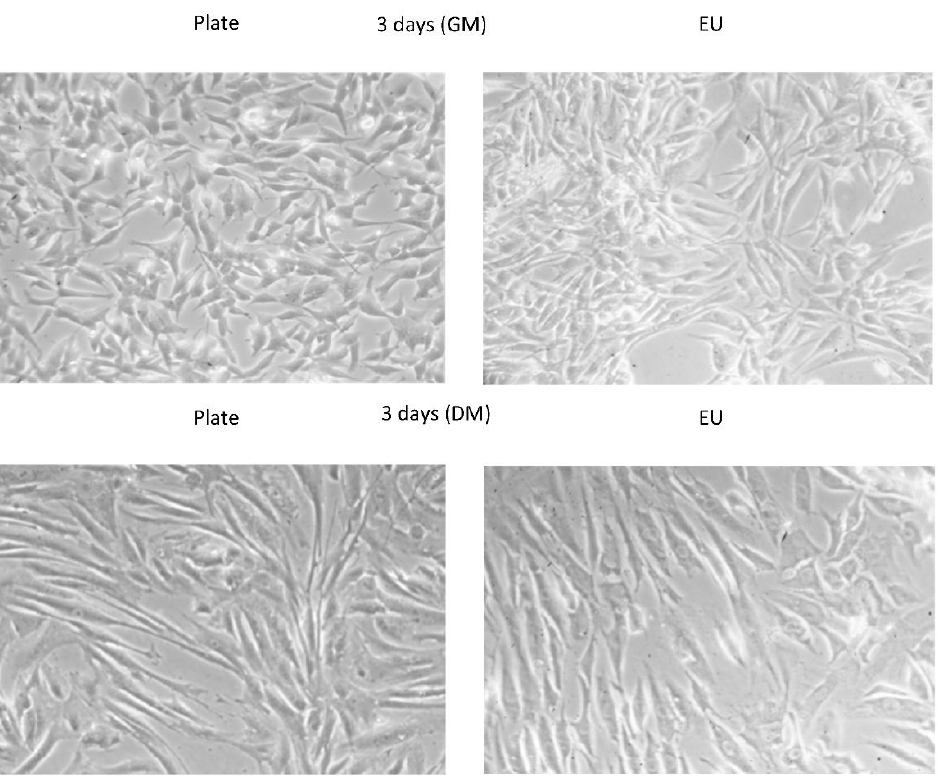
Figure 3. Myoblasts and myotubes after 3 days of culture in proliferation (GM) or differentiation (DM) conditions as viewed by phase-contrast microscopy. Magnification, 20×.